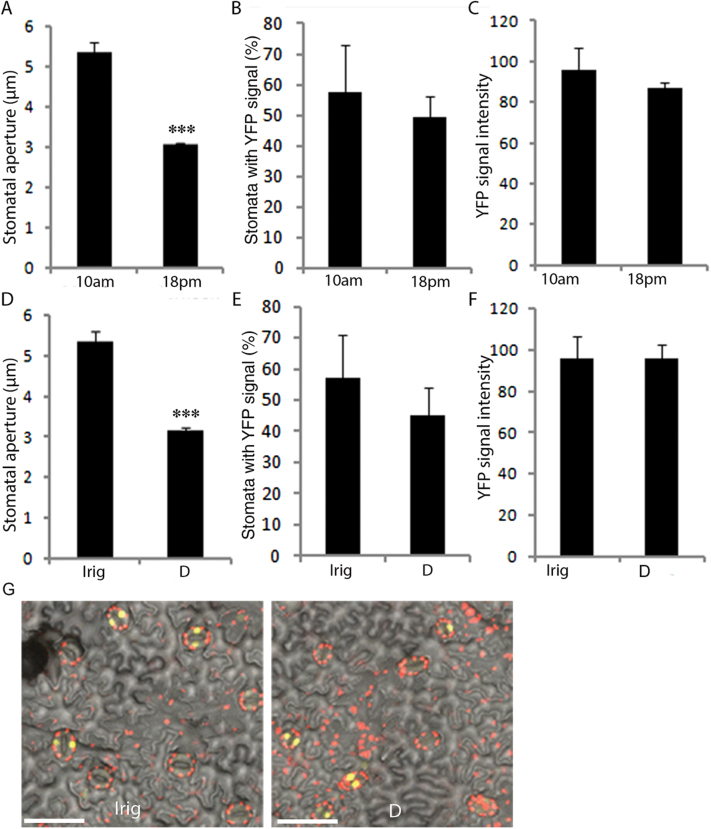
Stomatal aperture and TCS activity in guard cells of tomato during the day and in response to drought. (A) Stomatal aperture. (B) Percentage of stomata showing YFP signal. (C) YFP signal intensity. In (A) to (C), measurements were taken at 10.00 h and 18.00 h from TCSv2:3xVenus (YFP) leaves. (D) Stomatal aperture. (E) Percentage of stomata with YFP signal. (F) YFP signal intensity. In (D) to (F), measurements were taken at 10.00 h in irrigated (Irig) or mildly drought-stressed (D) TCSv2:YFP plants. In (A) to (F), values are means±SE of three replicates. Each replicate is the average of ~50 measurements (stomata). (G) YFP signal in guard cell nuclei of irrigated plants (Irig) and plants exposed to mild drought stress (D). Bars=50µM.